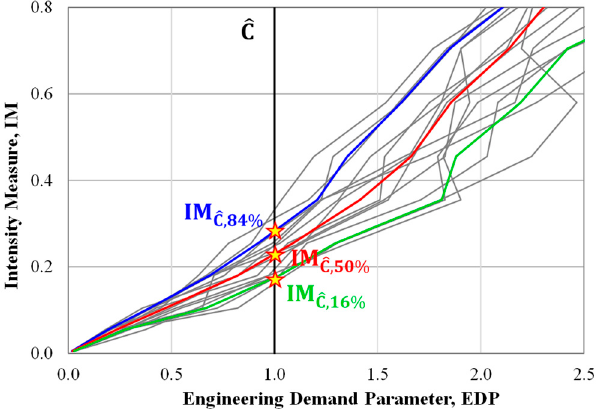
Figure 3. 16%, 50%, 84% summarized IDAs curves and corresponding values of IM at the level of capacity C (cid:3553) .